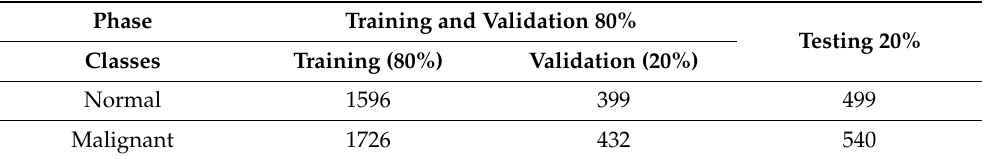
Table 1. Splitting of the OSCC data set through all phases for both